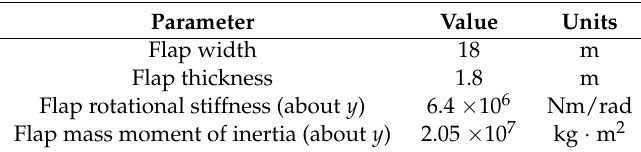
Table 4. Summary specifications of the pitching flap